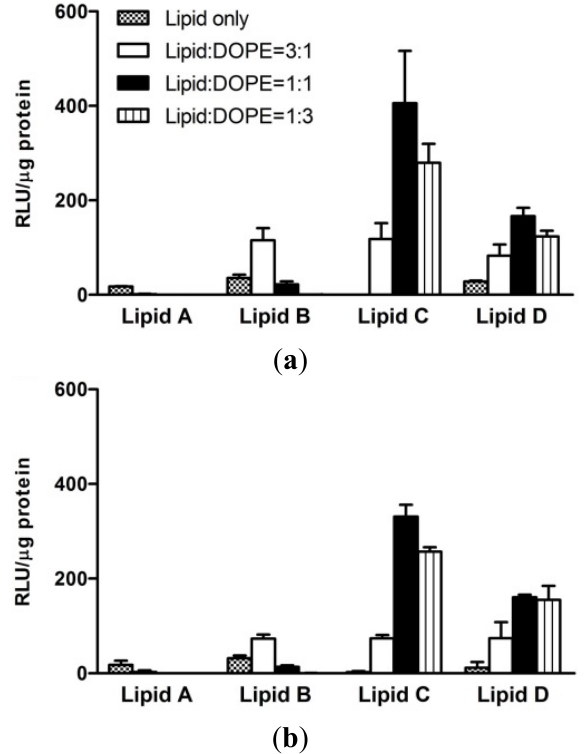
Figure 2. Transfection efficiencies at different lipid:DOPE weight ratios. In vitro transfection efficiencies of lipid/DNA complexes were measured using a luciferase assay at various lipid:DOPE weight ratios in AGS ( a ) and Huh-7 ( b ) cells. The lipid/DNA (N/P) weight ratio was kept constant at 2. Each bar represents the mean ± standard deviation (SD) of experiments performed in triplicate. RLU, relative luminescence